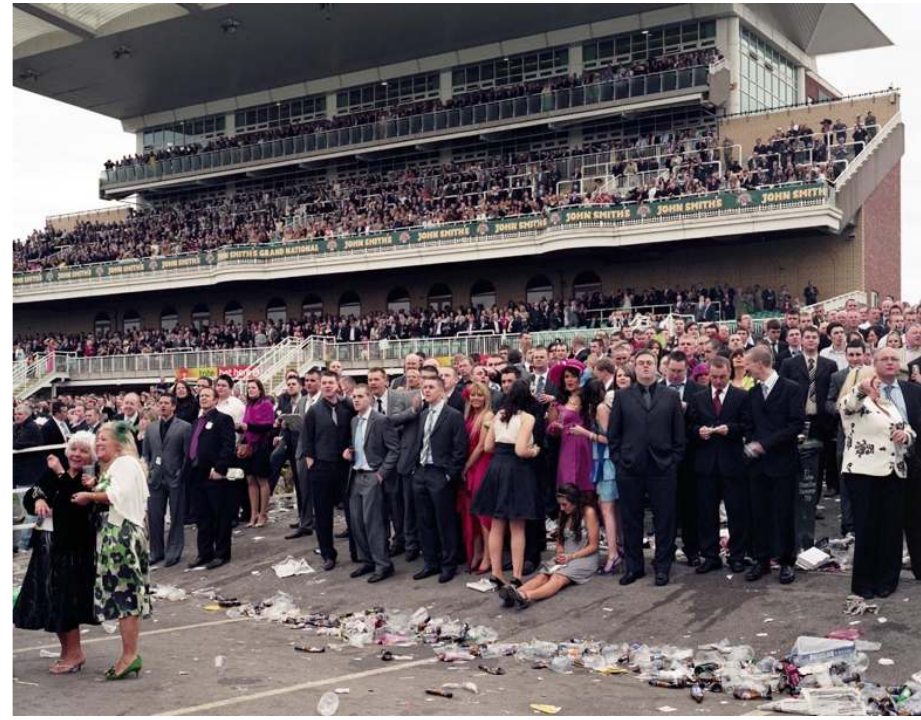
Figure 3: Simon Roberts, ‘Derby Day at